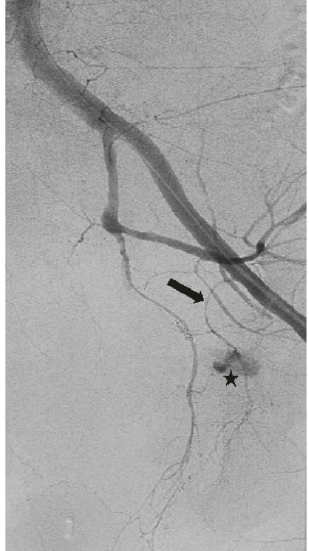
Figure 3: Left common iliac angiogram. Active extravasation (star) is seen from a left corona mortis (arrow). In this case, the internal and external iliac communication arises from an aberrant pubic branch. This aberrant pubic branch originates from the left external iliac artery proximal to the origin of inferior epigastric artery.